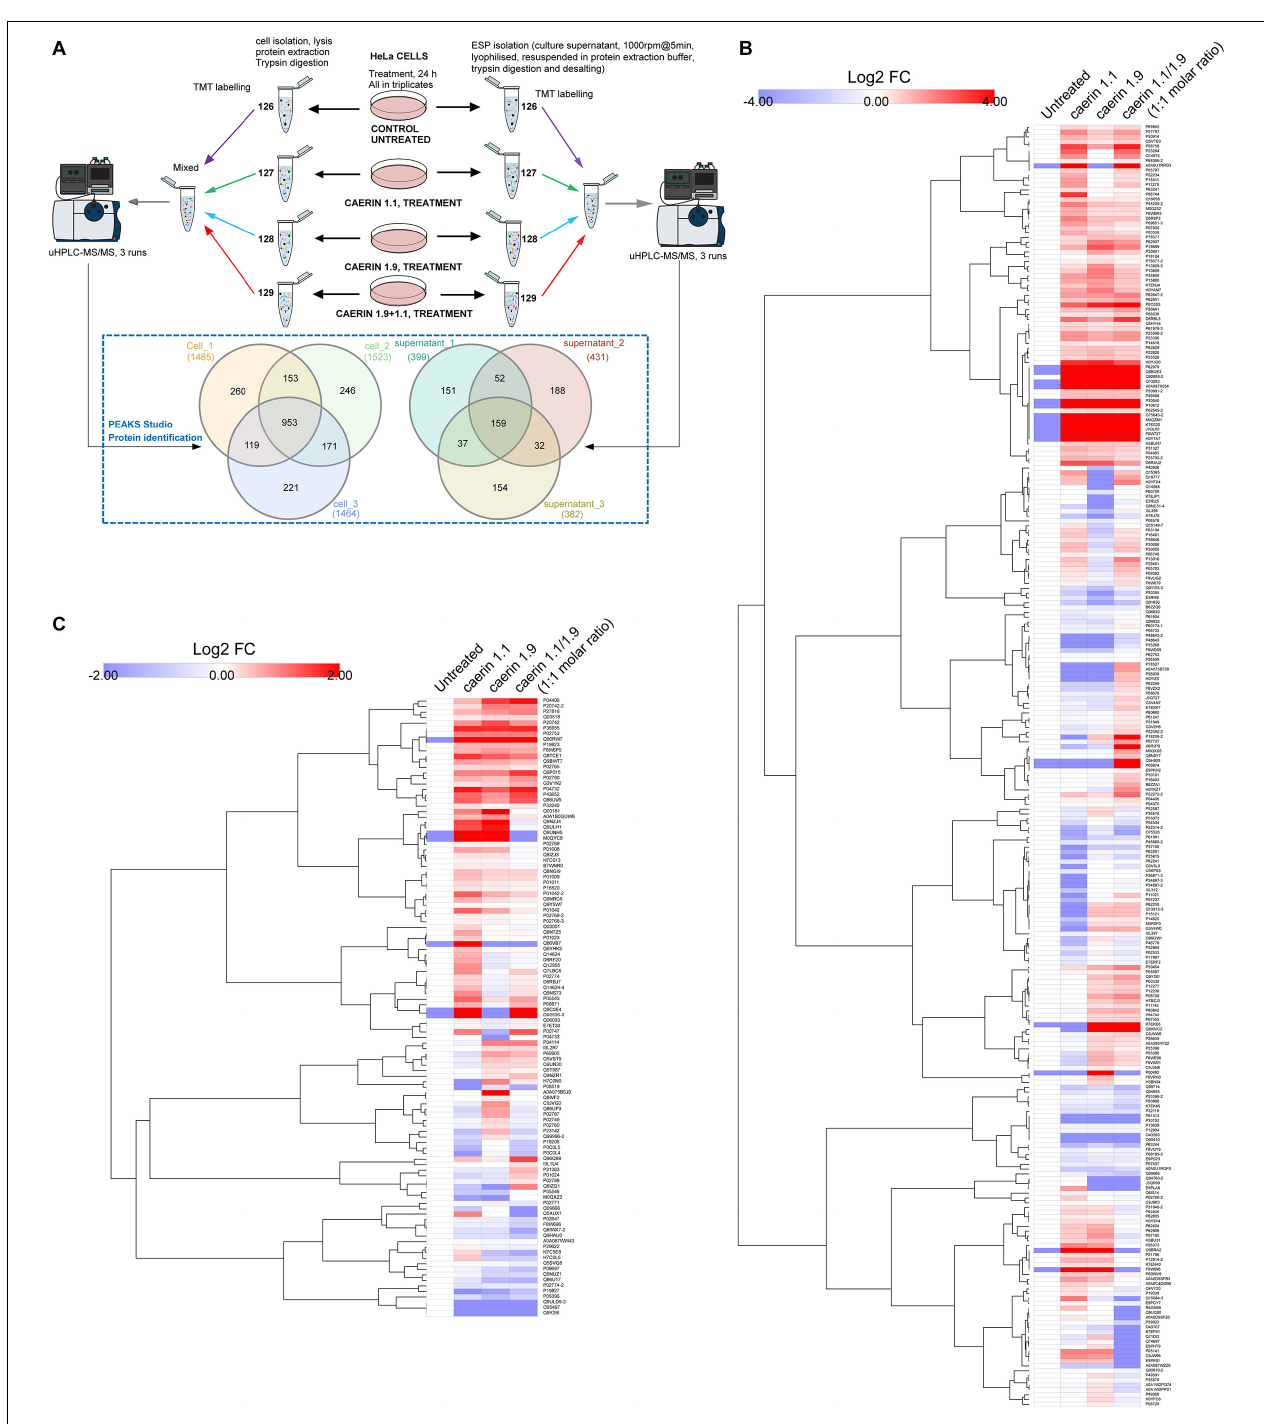
FIGURE 4 | Quantitative proteomic analysis of the anti-proliferative activities caerin 1.1, 1.9 and their mixture (molar ratio 1:1) against breast cancer HeLa cells using quantitative proteomics. (A) Overall workflow for TMT labeling and uHPLC QTOF MS/MS analysis of cell and supernatant proteins/peptides extracted from untreated and peptide treated cells. The Venn diagram shows the comparison of proteins identified in biological triplicates of cell and cell supernatant samples (see Supplementary Tables 1 , 2 for accessions of identified proteins, supporting peptides and protein annotations). (B) The hierarchy clusters of differentially expressed proteins (shown in Log2FC values) identified from cell samples ( n = 3) post the peptide treatment (see Supplementary Figure 1–3 for proteins quantified in each replicate and Supplementary Table 3 for corresponding feature peptides). (C) The hierarchy clusters of differentially expressed proteins (shown in Log2FC values) identified from cell environment (supernatant) samples ( n = 3) post the peptide treatment (see Supplementary Figures 4–6 for proteins quantified in each replicate and Supplementary Table 4 for corresponding feature peptides).